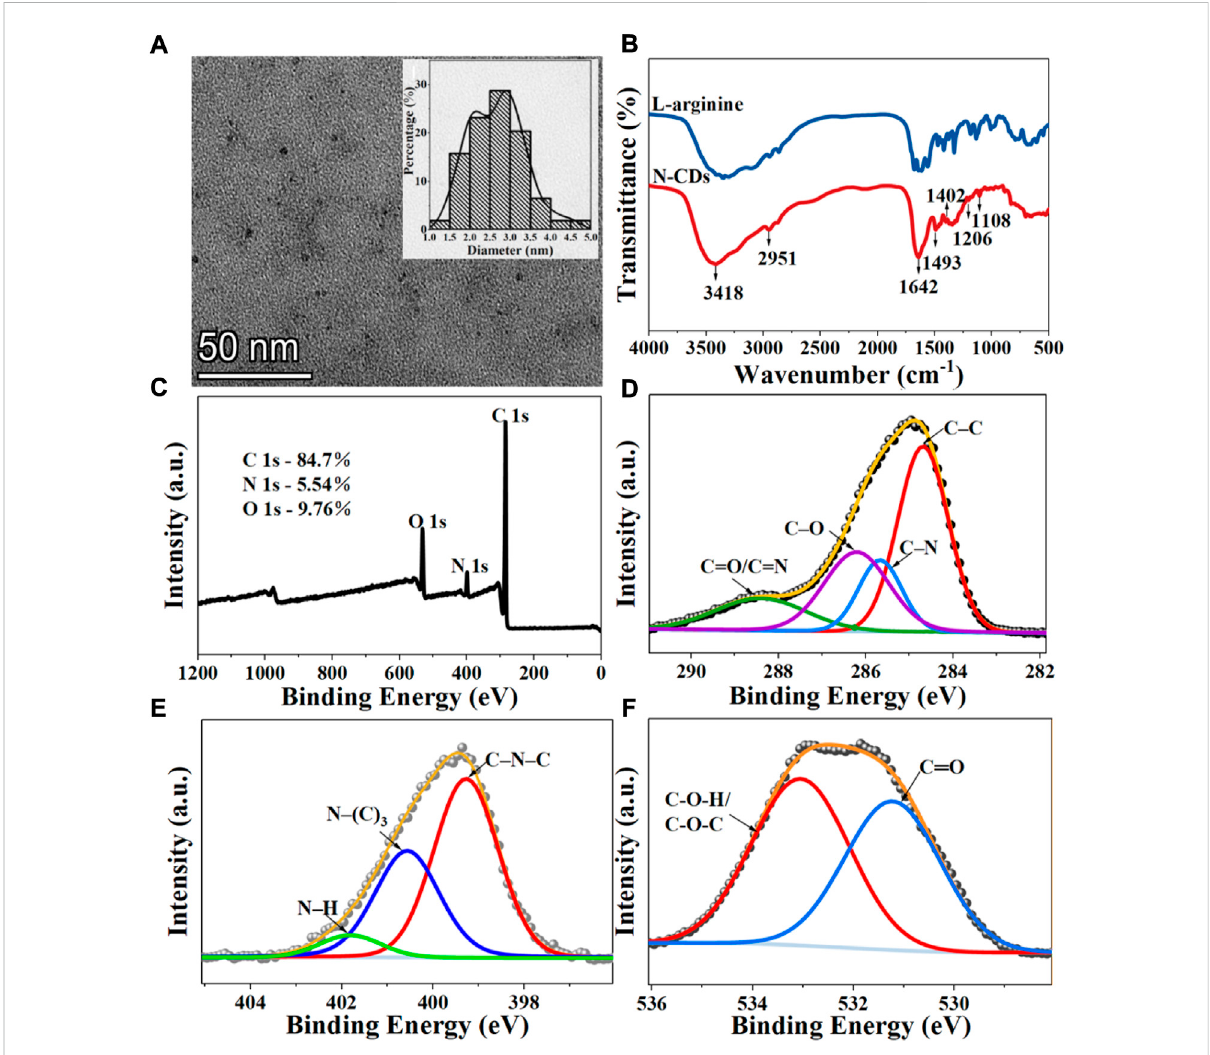
FIGURE 2 Characterization of N-CDs: (A) TEM images. Inset: Size distribution diagrams of N-CDs; (B) FT-IR spectra of L -arginine and N-CDs; (C) Full survey XPS spectra of N-CDs; (D) C 1s XPS spectra of N-CDs; (E) N 1s XPS spectra of N-CDs; (F) O 1s XPS spectra of N-CDs.